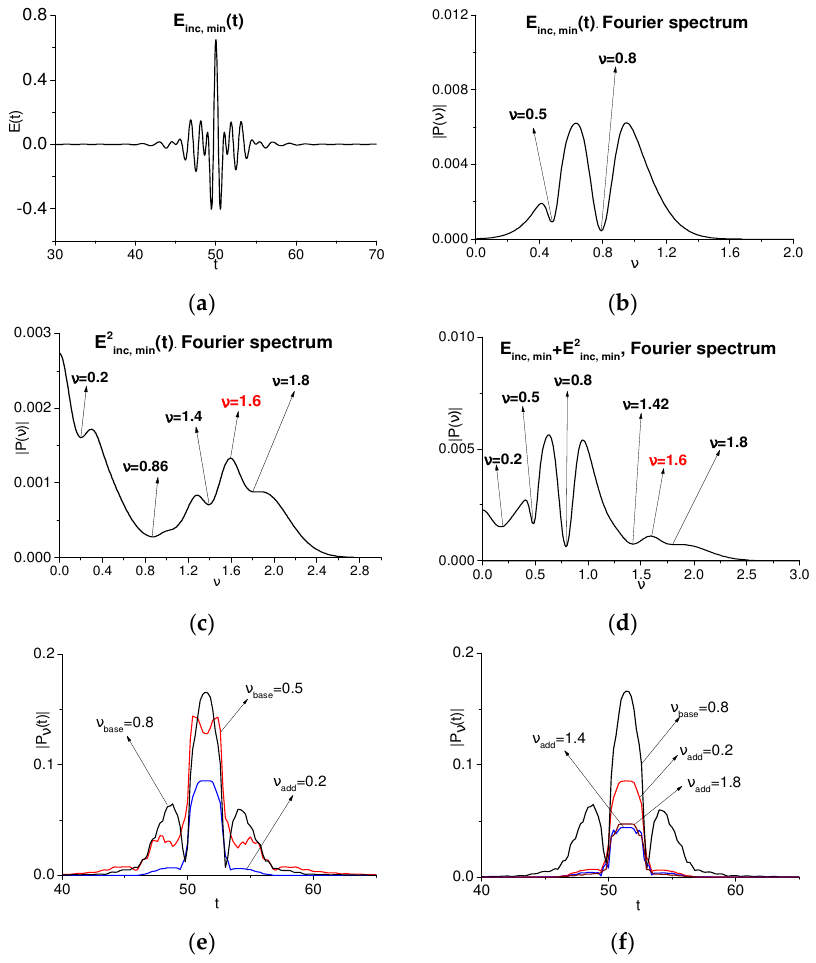
Figure 7. Artificial signal E inc ,min ( t ) ( a ), its spectrum ( b ), and the spectra of the signals E 2 inc ,min ( t ) ( t ) + χ ( 2 ) · E 2 ( t ) , χ ( 2 ) ( c ), E = 1 ( d ); the spectral lines dynamics at the basic frequencies inc ,min inc ,min dl dl ν base = 0.5, 0.8 and additional frequencies ν = 0.2 ( e ), 0.2, 1.4, 1.8 ( f ) [36]. The spectral line dynamics computed at the basic frequencies ν base = 0.5, 0.8 and at